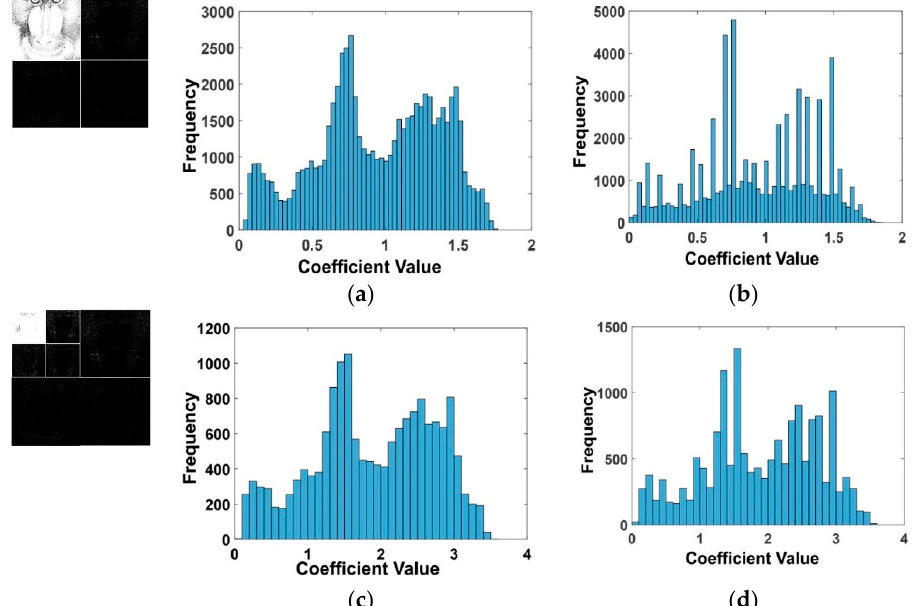
Figure 3. Histogram analysis before and after embedding baboon image in 1DWT and 2DWT: ( a ) 1DWT histogram before embedding, ( b ) 1DWT after embedding, ( c ) 2DWT histogram before embedding, and ( d ) 2DWT histogram after embedding.